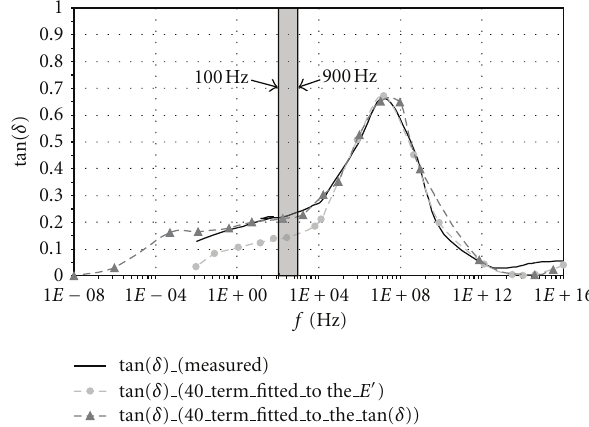
Figure 8: tan( δ ) versus frequency curves of EPDM v2 in case of two di ff erent 40-term generalized Maxwell-model at room